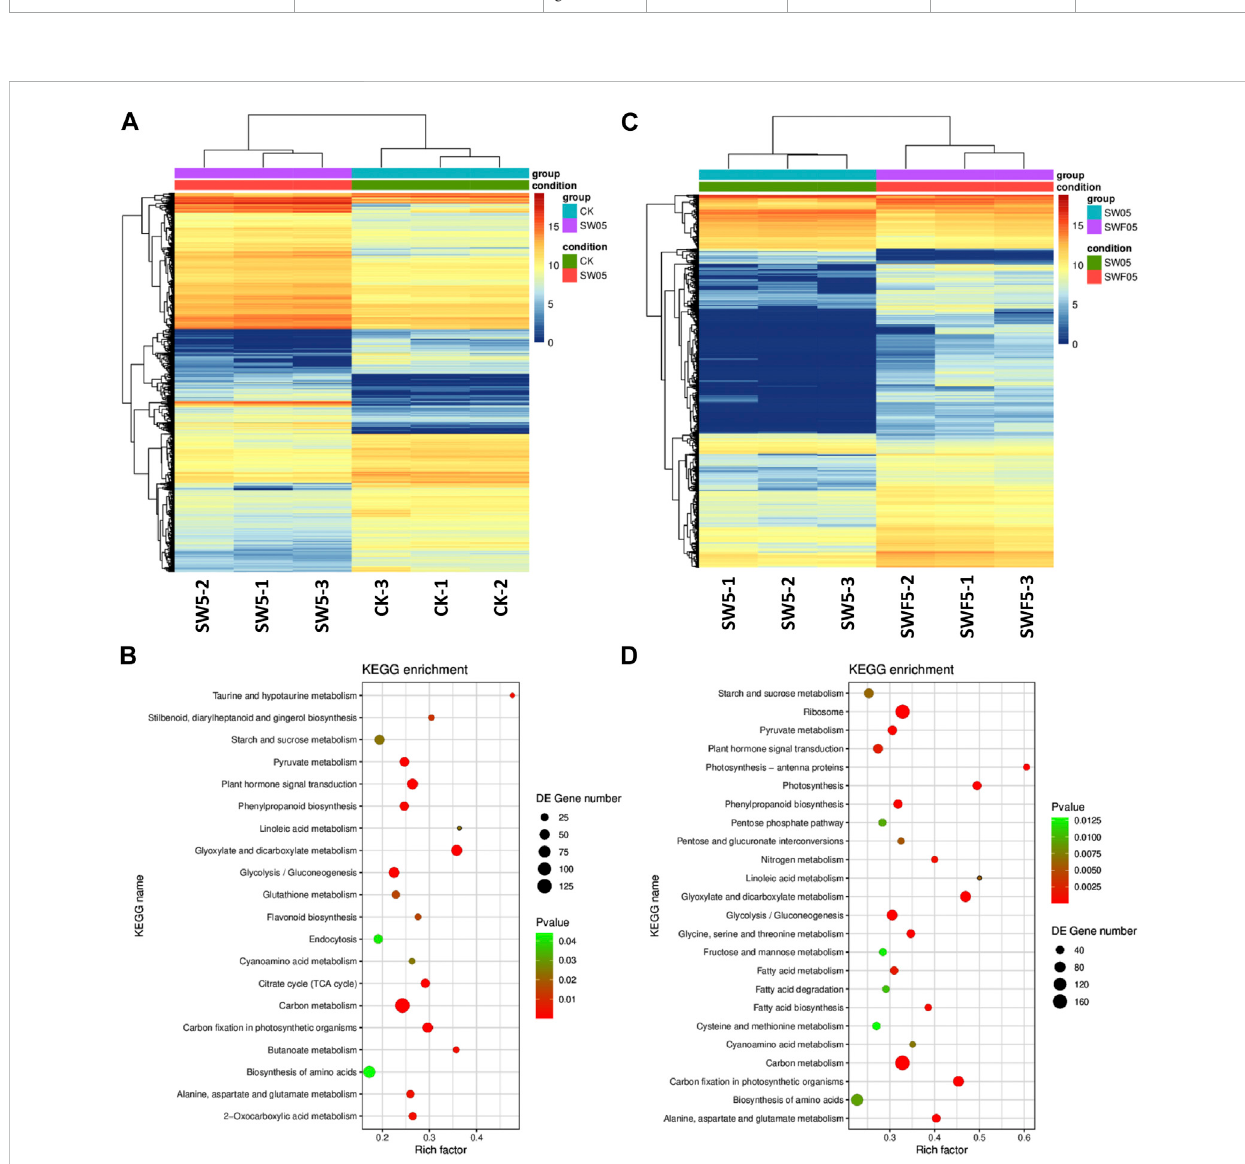
FIGURE 6 Drought stress and rewatering after drought stress driven transcriptome changes in Adiantum leaves. (A) Heat map representation of expression pro fi les for differentiallyregulatedgenesinresponseto5 daysofdroughtstress, (B) Heatmaprepresentationofexpressionpro fi lesfordifferentiallyregulatedgenesafter5 days ofrewatering. (C) ScatterplotshowingthepathwaystowhichtheDEGsweresigni fi cantlyenrichedupondroughtstressand, (D) Scatterplotshowingthepathways to which the DEGs were signi fi cantly enriched after 5 days of rewatering. Where, CK = control, SW05 = drought stress for 5 days, and SWF05 = 5 days after